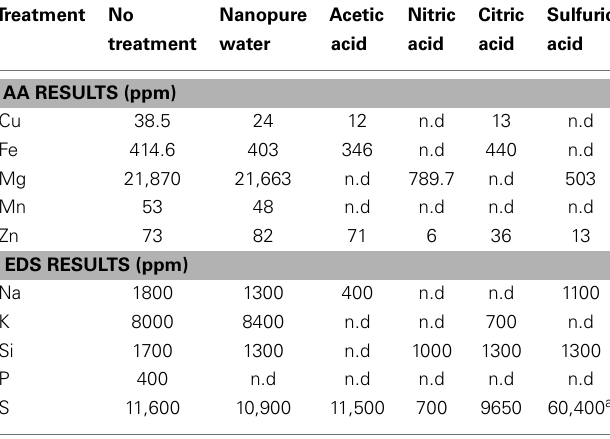
Table 2 | Elemental analysis in untreated and treated biomasses